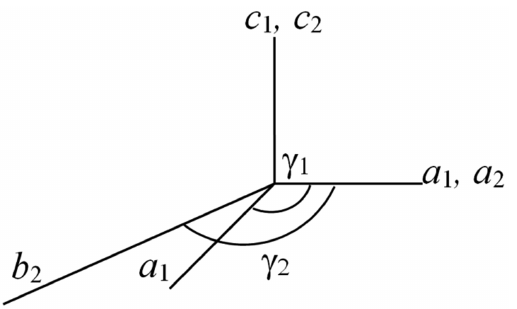
Figure 8: Scheme of changing of apatite crystal symmetry from hexagonal (a1, c1, γ 1) to monoclinic (a2, b2, c2, γ